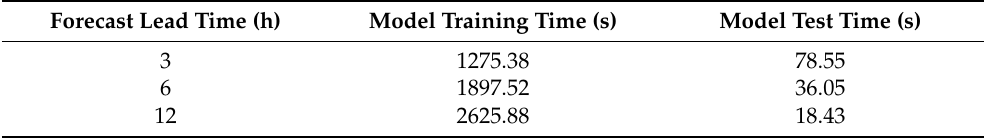
Table 4. The average computation time to train the neural network model for 50 epochs and the computation time to run the neural network model for 50 test storms using three forecast lead times (i.e., 3 h, 6 h, and 12